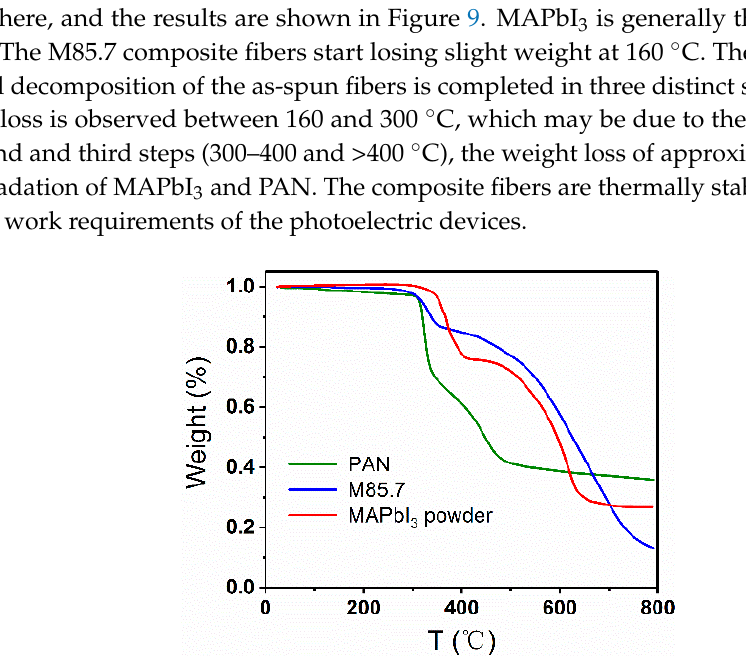
Figure 9. TGA curves of the M85.7 fibers, PAN fibers, and pure MAPbI 3 powder.